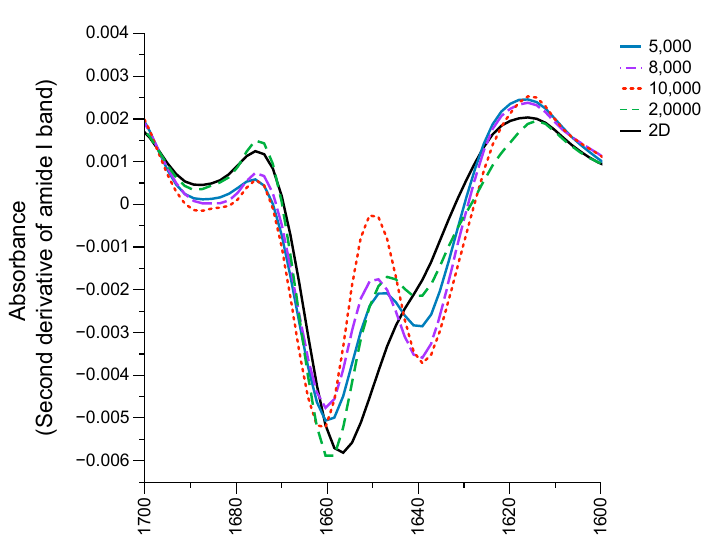
Figure 7. Second derivative of average spectra in the amide I region (between 1600 and 1700 cm − 1 ) between 2D cells (solid black line), 5000 spheroid cells ( solid blue line ) , 8000 spheroid cells ( purple dot - dashed line ) , 10,000 spheroid cells ( red dotted line ) , and 20,000 spheroid cells ( green dashed line ) .